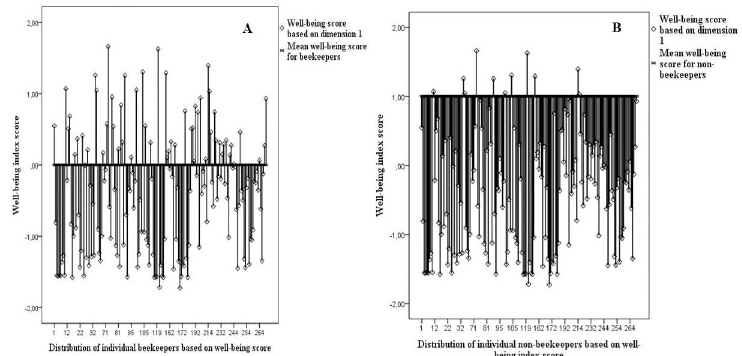
Fig 1. Comparing the mean well-being score for beekeepers and non-beekeepers A) indicates a low mean score which according to the study measurements signify less wealthy households, while B) shows a higher mean score implying non-beekeeping households were slightly wealthier than the beekeepers. All measurements basedon dimensionone